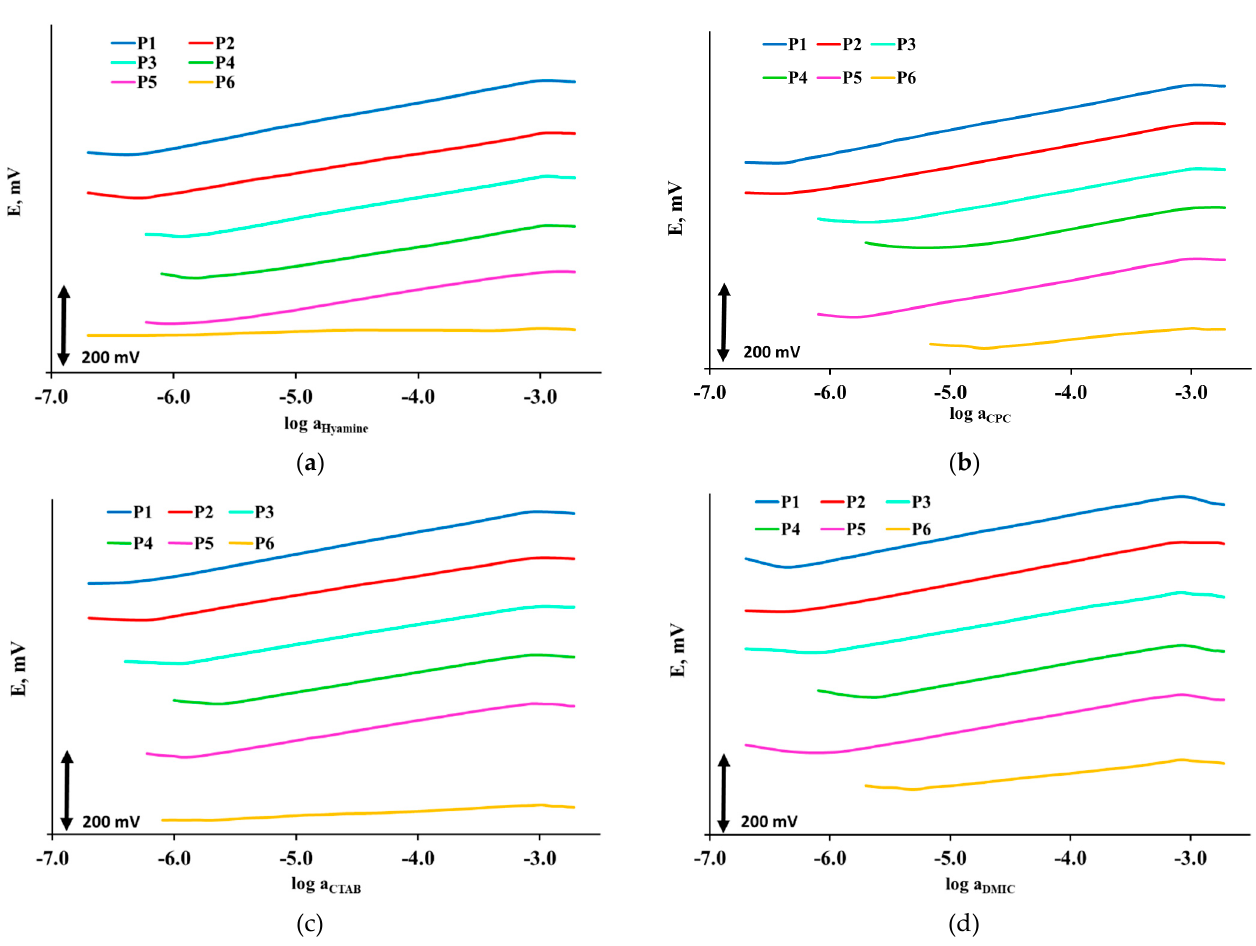
Figure 1. Response curves of the surfactant sensors toward ( a ) Hyamine 1622, ( b ) CPC, ( c ) CTAB and ( d ) DMIC in deionized water, for membranes containing six different plasticizers, from top to the bottom: 2-nitrophenyl-octyl-ether (P1), bis(2-ethylhexyl) phthalate (P2), bis (2-ethylhexyl) sebacate (P3), 2-nitrophenyl phenyl ether (P4), dibutyl phthalate (P5), dibutyl sebacate (P6).